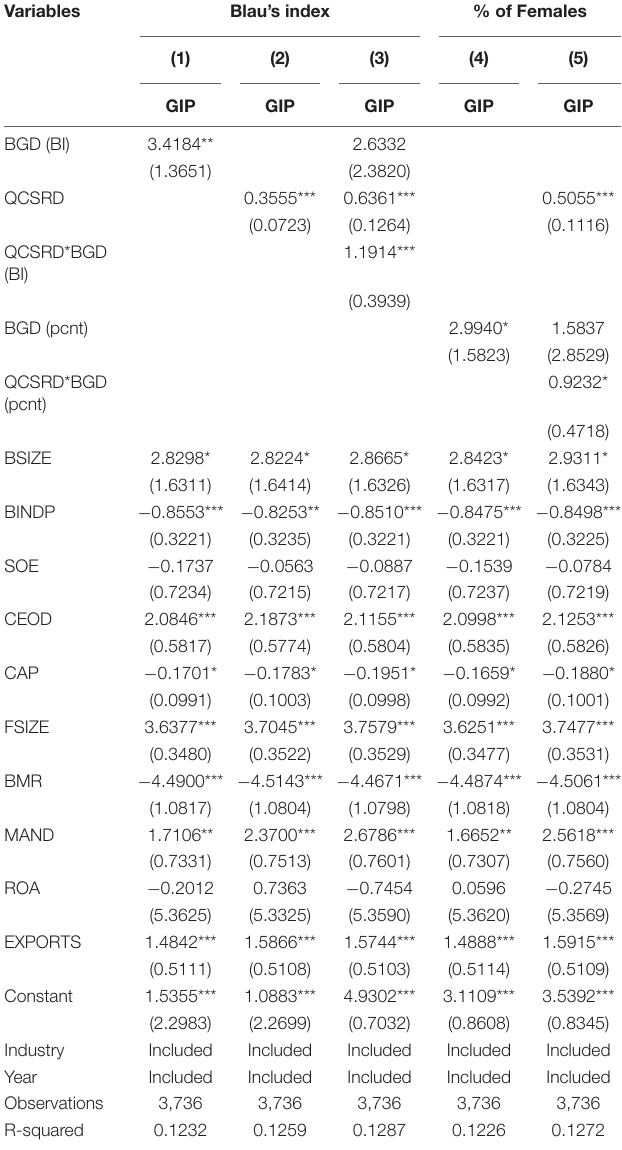
TABLE 3 | Main regression results based on